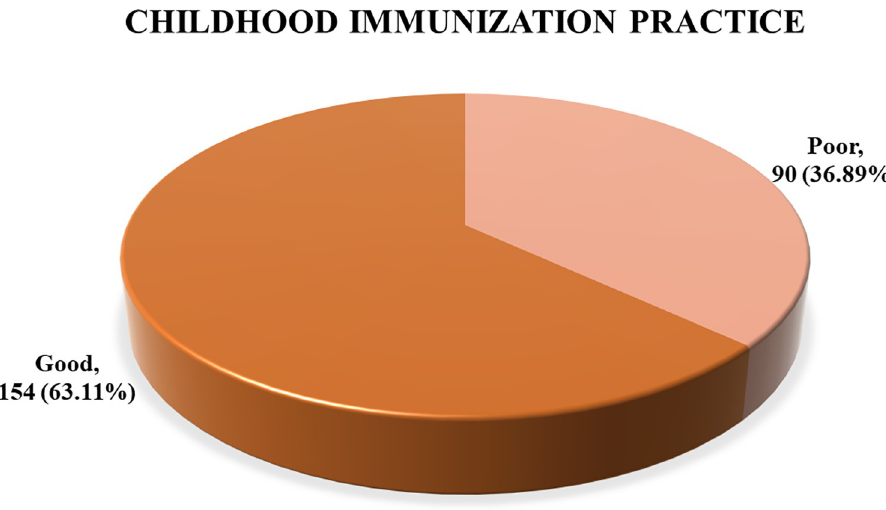
Fig 1. Childhood immunization practice pattern among Rohingya refugee